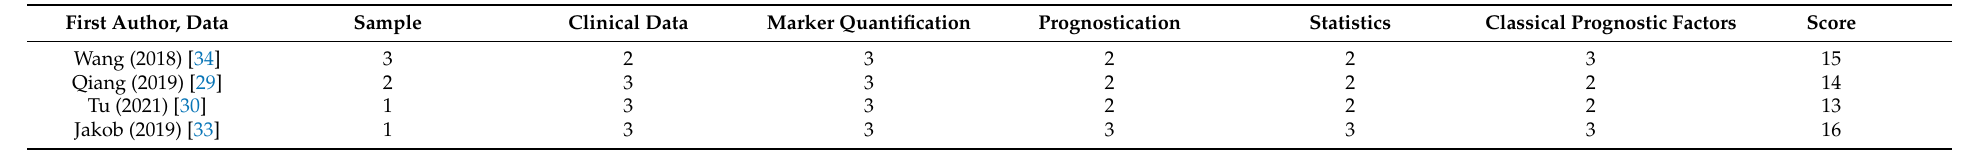
Table 3. Assessment of risk of bias within the studies, with scores 8 to 10 = low quality, 11 to 14 = intermediate quality, and 15 to 18 = high